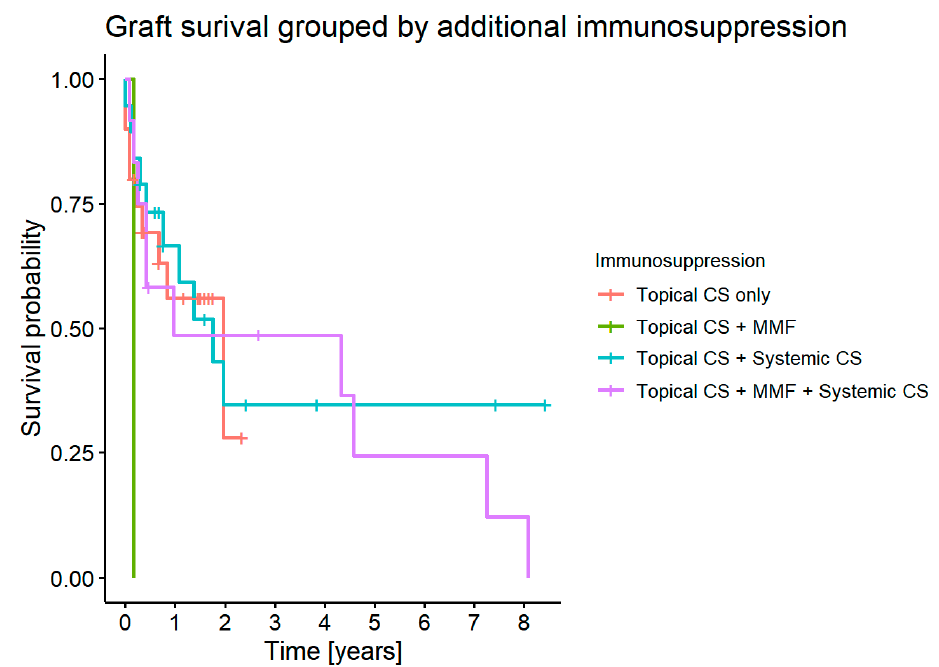
Figure 11. Graft survival grouped by the use of immunosuppression.